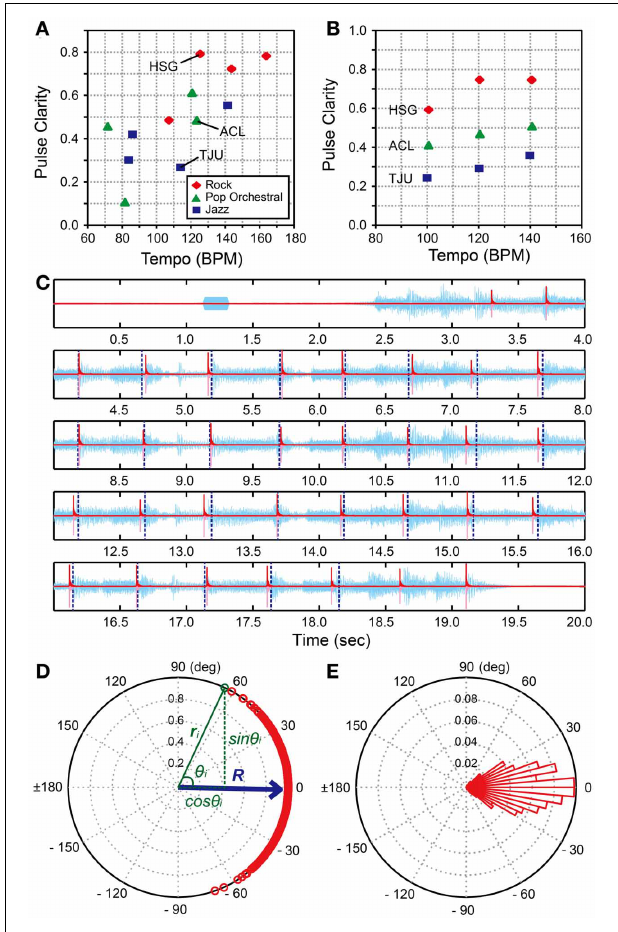
FIGURE 3 | Music tapping test (MTT). (A) BPM—pulse clarity plots of 12 musical excerpts used in the beat alignment test (BAT) (Iversen and Patel, 2008). We selected 3 excerpts (i.e., HSG, Hurts So Good by J. Mellencamp; TJU, Tuxedo Junction by Glenn Miller; and ACL, A Chorus Line by Boston Pops) for the Harvard Beat Assessment Test (H-BAT). (B) BPM—pulse clarity plots of 9 musical excerpts used in the H-BAT. (C) An example of recorded tapping signal (pink), its envelope (red), and audio wave during playing HSG (light blue). Vertical blue dashed lines represent the quarter-note beat timings (Iversen and Patel, 2008). (D) A plot of relative phases between tap onsets and beat timings ( n = 486) on a unit sphere across 18 trials (9 stimuli × 2 trials) in a participant (red). The resultant vector ( R ) is shown as blue arrow. (E) A histogram of the relative phases. Each bin has a range of 5 ◦